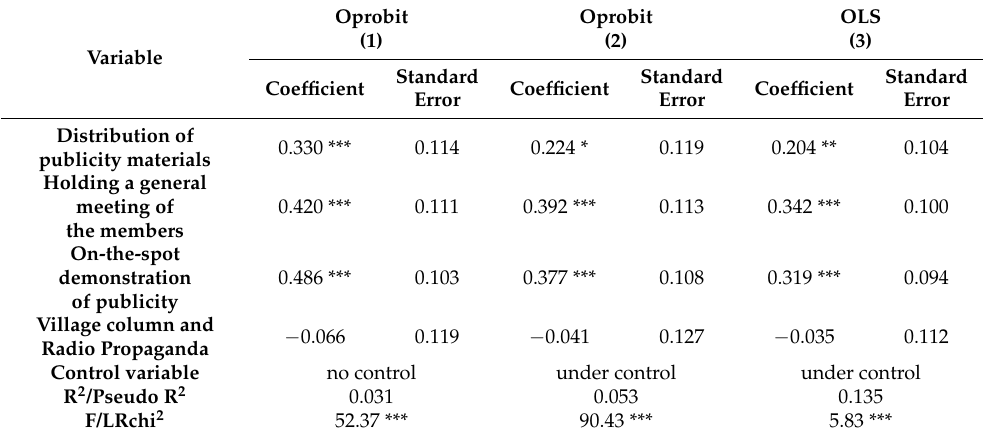
Oprobit Oprobit OLS (1) (2) (3) Standard Standard Standard Coefficient Coefficient Coefficient Error Error Error 0.330 *** 0.114 0.224 * 0.119 0.204 ** 0.104 0.420